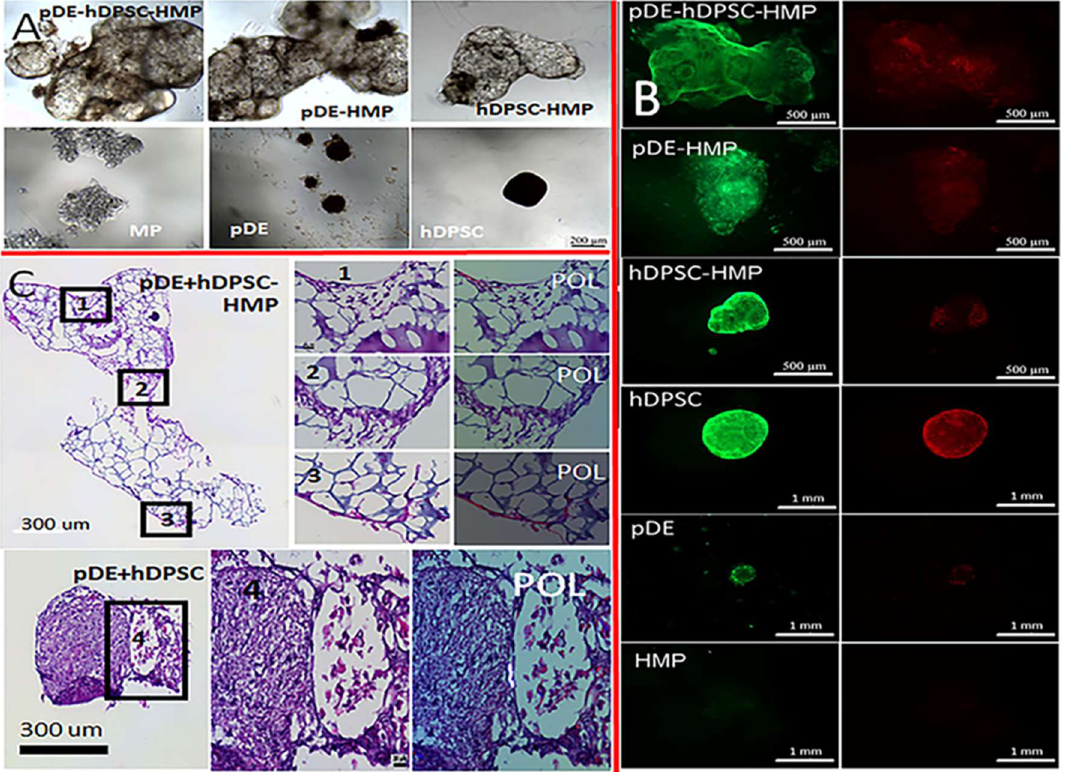
Figure 4. Tooth-bud organoids after 1-week in vitro culture: ( A ) Bright field image of co-cultured pDE and hDPSC cell clusters shows that clusters cultured with HMPs appear larger and better-organized than those without HMPs. ( B ) Live-Dead assay showed higher viability for cells cultured with HMPs. Green fluorescence indicates live cells, and red fluorescence indicates dead cells. ( C ) Brightfield and polarized light microscopy (POL) of H&E-stained co-cultured constructs showing that pDE cells displayed a typical clustered morphology (1) while hDPSCs exhibited typical spindle shaped morphology (3). Clear cell–cell contact between polarized cell types was observed in constructs with HMP (2), but not in constructs without HMP, although both types of cell were present in co-cultured constructs (4). Scale bar = 200 µm ( A ), 500 µm (( B ), with HMP), 1 mm (( B ), cell alone), 300 µm ( C ), 20 µm (Panels 1–4, 1′–4′). Analyses of 2-week-cultured constructs are shown in Supplementary Figures S4 and S5.